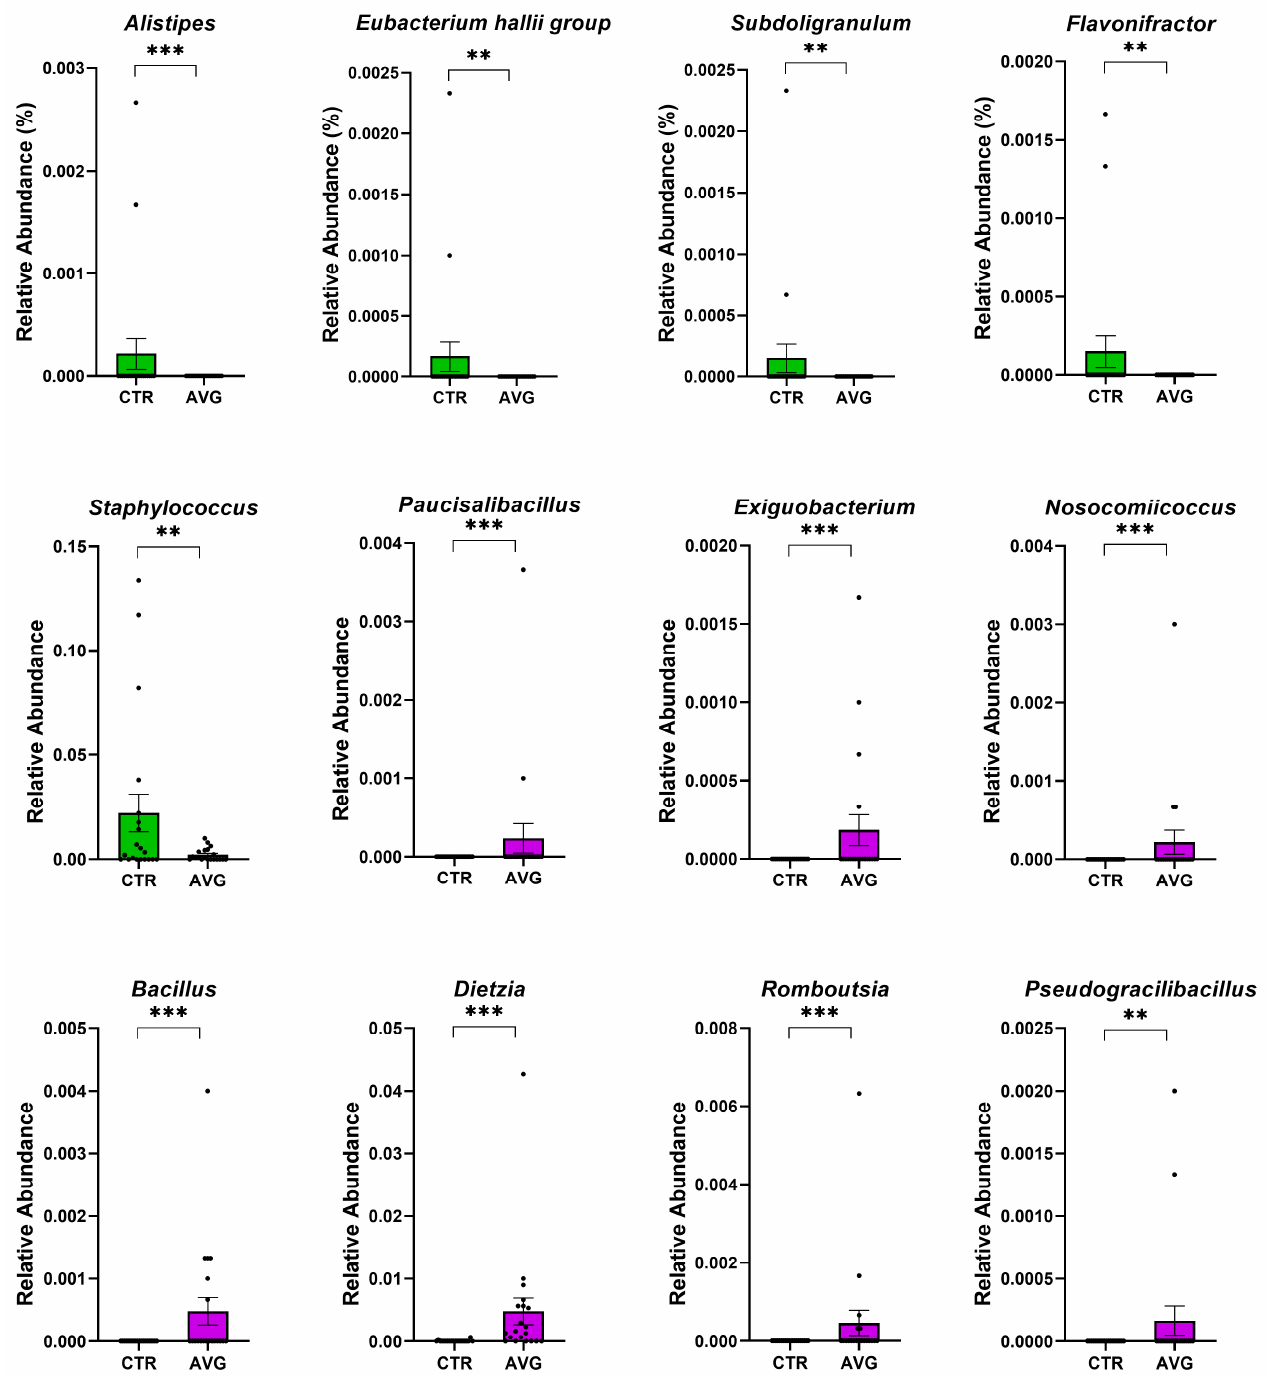
Figure 7. Metastats selected differentially ( p < 0.001) abundant genera in the crop. The asterisk indicates significance level (*** p < 0.001; ** p < 0.01). Each dot represents one sequenced sample relative abundance.